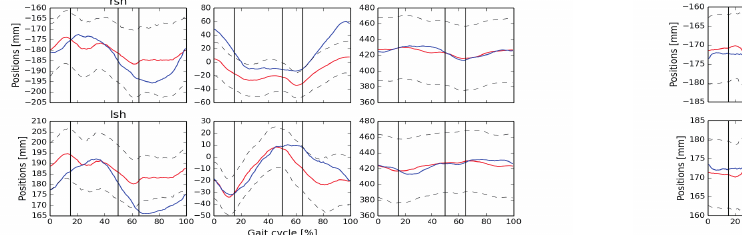
Figure 11: Comparison of waist positions